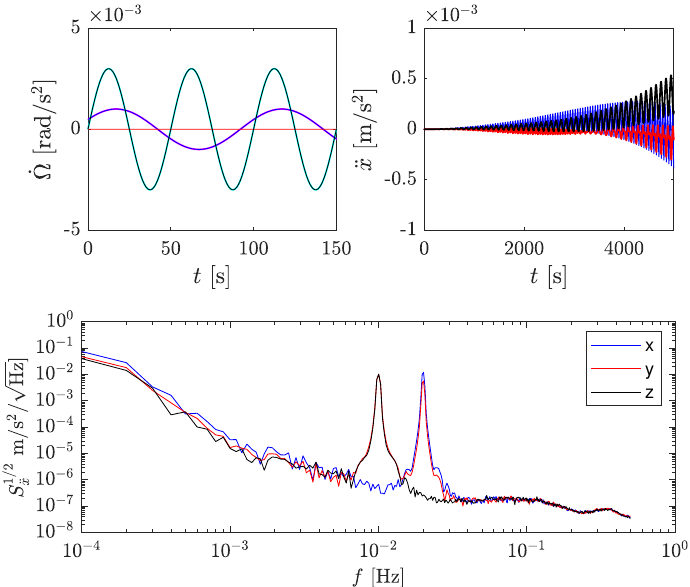
Figure 10. Simulation results when injecting angular accelerations. ( Top left ): recovered angular acceleration. ( Top right ): recovered linear acceleration, where the effect of the angular velocity is clearly visible. ( Bottom ): linear acceleration square root of the PSD. The peaks at 10 and 20mHz appear due to the angular velocity